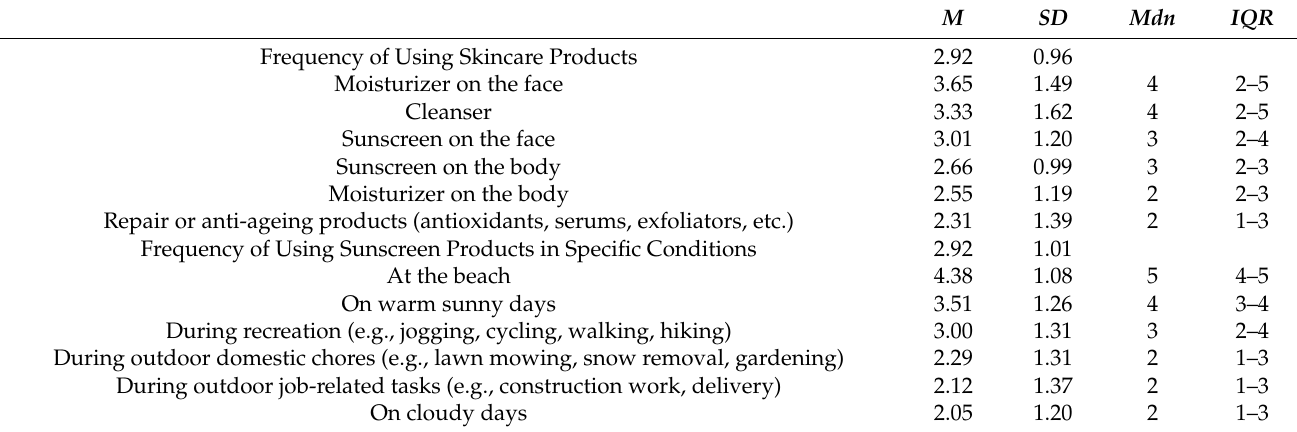
Table 1. Descriptive statistics of items and total score for skincare and sunscreen use.